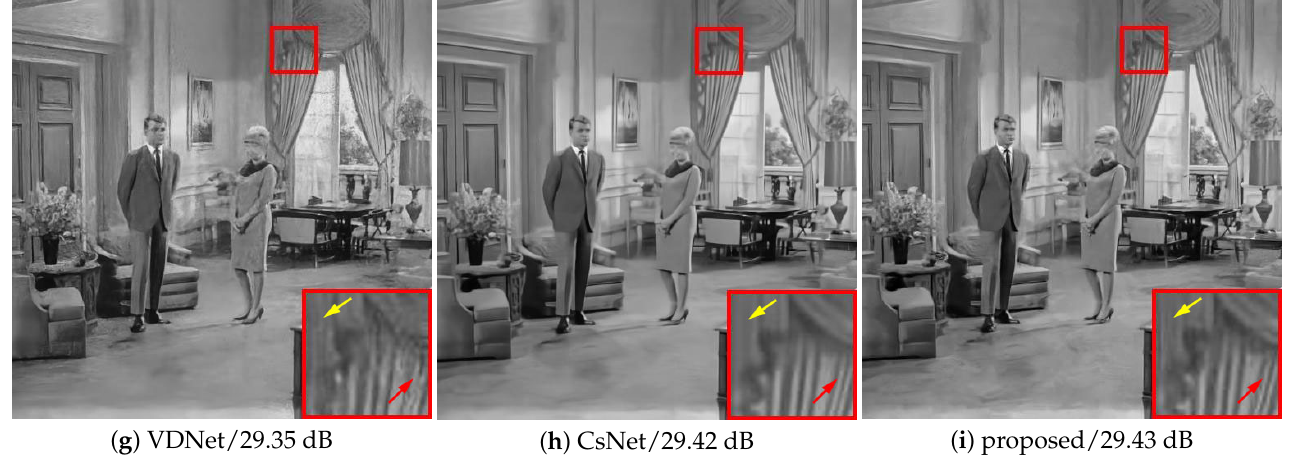
Figure 7. Denoising results of Couple image with noise level σ = 30.